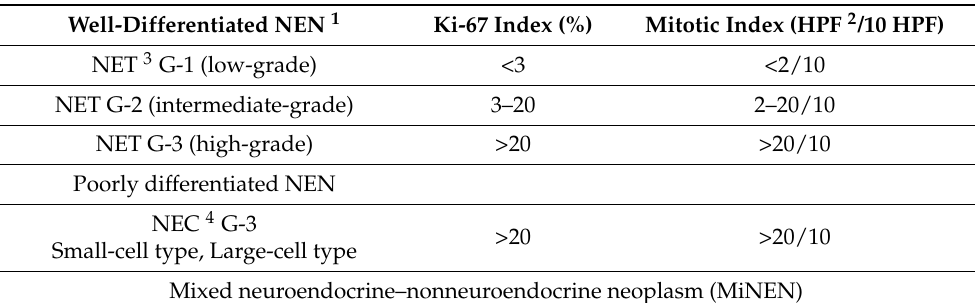
Table 1. The 2019 World Health Organization (WHO) classification for neuroendocrine neoplasms (NEN) of the digestive tract. Well-Differentiated NEN